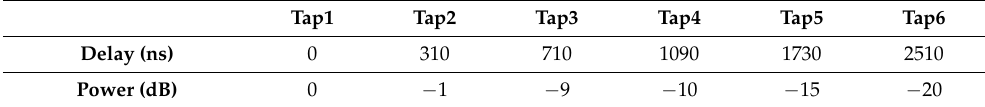
Table 4. Multipath profile of the vehicular A outdoor channel model.